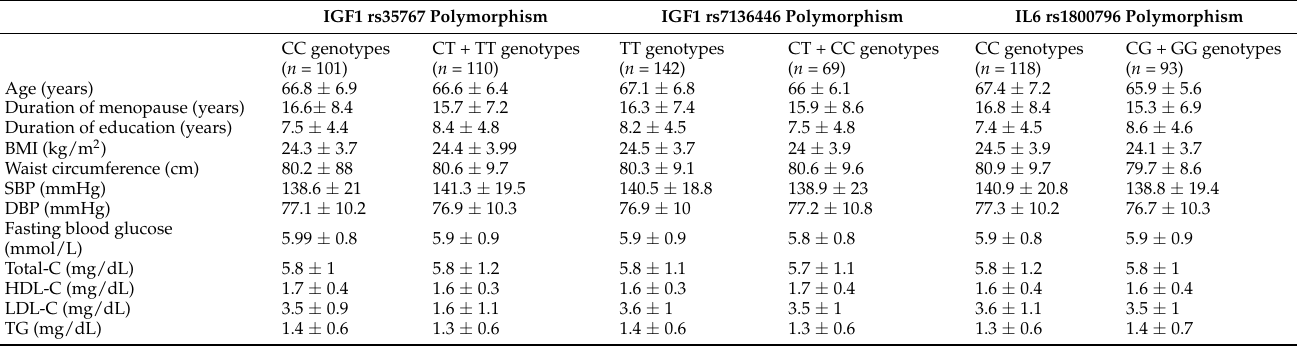
files (WC, SBP, DBP, blood glucose, total cholesterol, HDL, LDL, and triglycerides) were comparable between the major allele for each genotype. Table 3. Demographic and metabolic traits according to SNPs rs35767, rs7136446, and